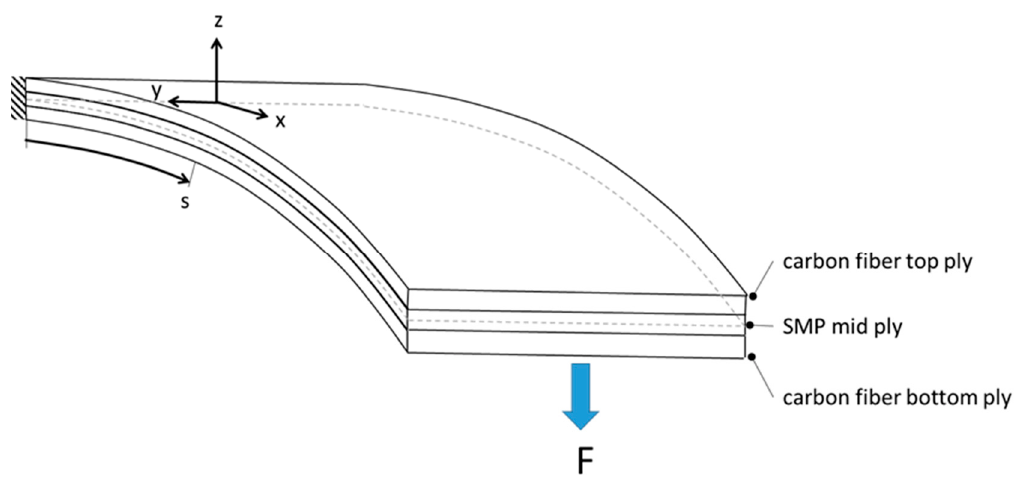
Figure 2. Scheme of the laminate.